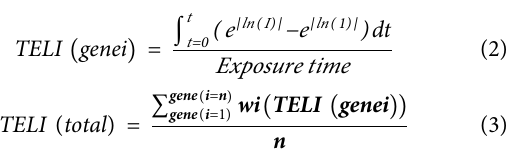
Frontiers in Environmental Science |